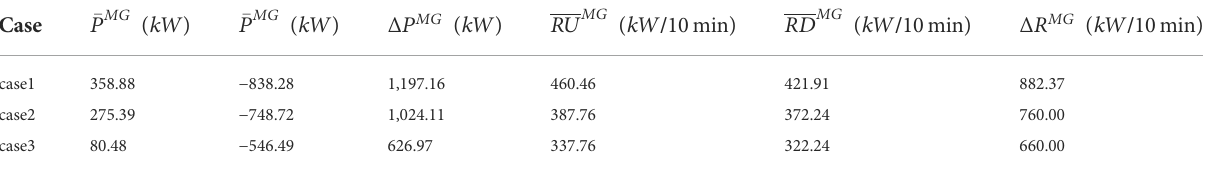
TABLE 5 Results of MG-FPs in different system con fi guration cases.